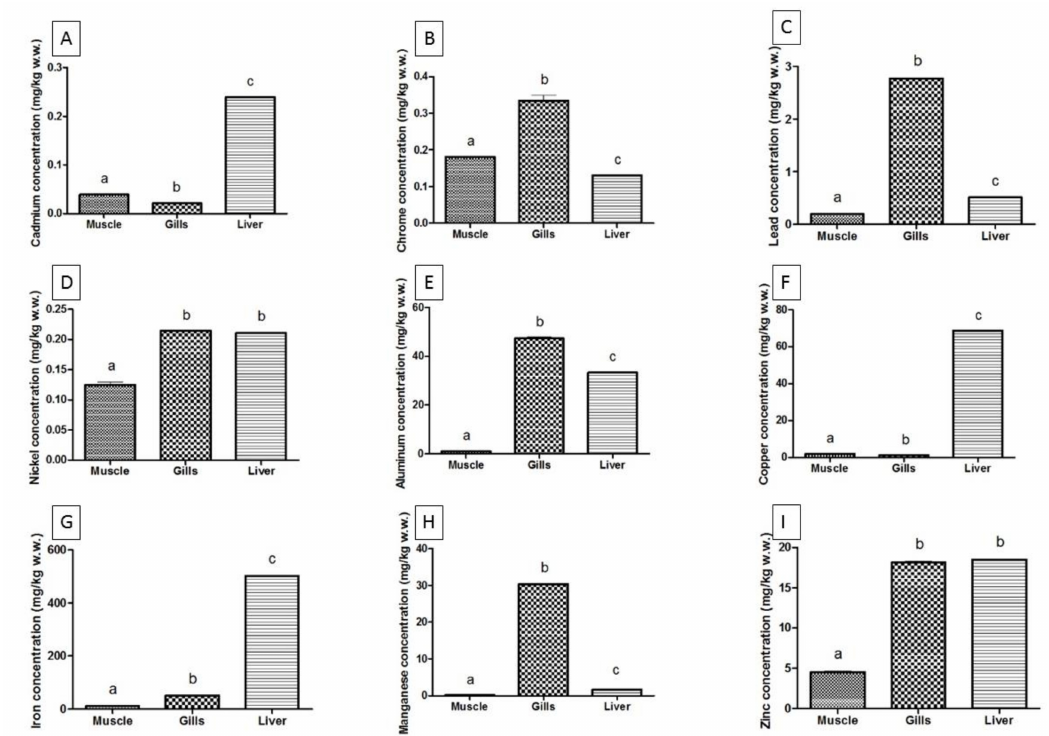
Figure 3. Metal concentrations in di ff erent tissues of Mugil cephalus (Linnaeus, 1758) from the Black Sea, Bulgaria. Di ff erent alphabetical characters represent statistical di ff erences ( p < 0.05). From ( A – I ) are plotted metal concentrations in the following order: Cd, Cr, Pb, Ni, Al, Cu, Fe, Mn, and